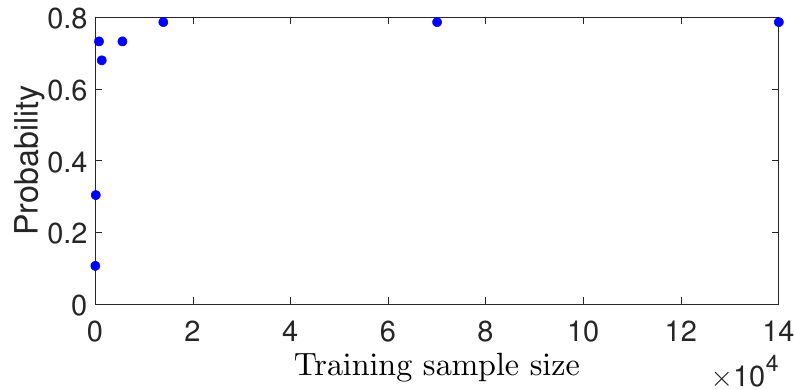
Figure 9. Probability of closed-loop stability vs. training sample sizes.